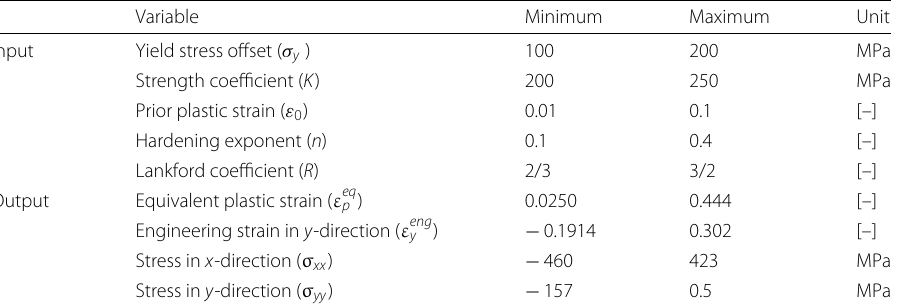
Table 1 Ranges and dimensions of the input and output of the pure bending